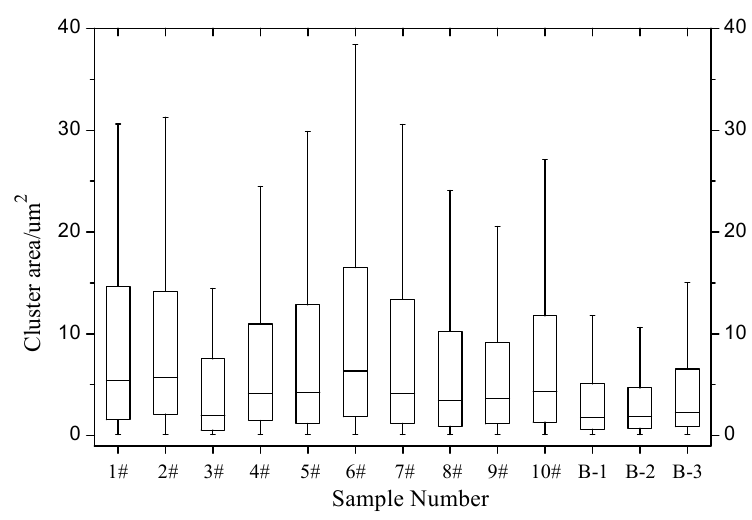
Figure 11. Box plot of graphene cluster area.